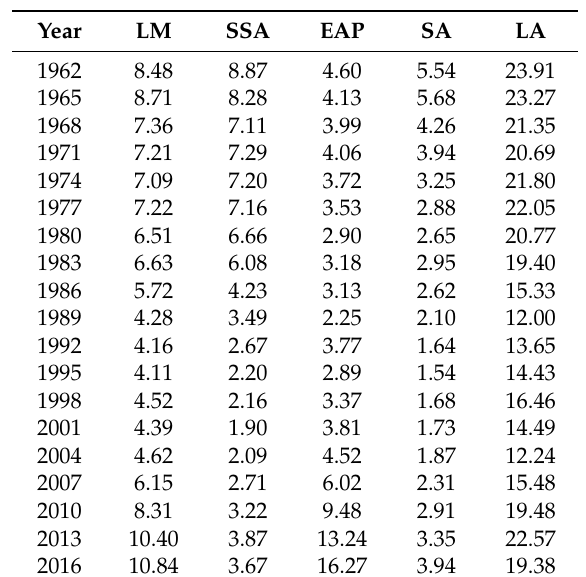
Table 1. Per capita income in low- and middle-income countries (LM), Sub-Saharan Africa (SSA), East Asia and Pacific (EAP), South Asia (SA), and Latin America (LA) as a percentage of per capita income in high-income countries,